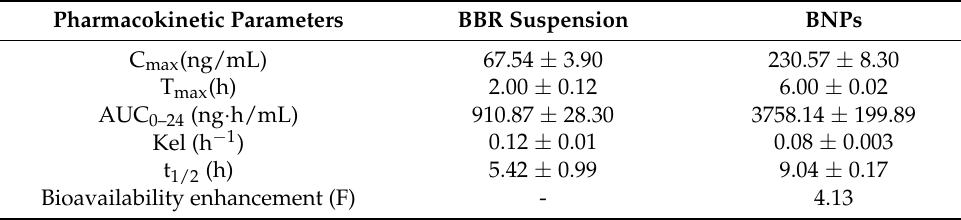
Table 5. Pharmacokinetic